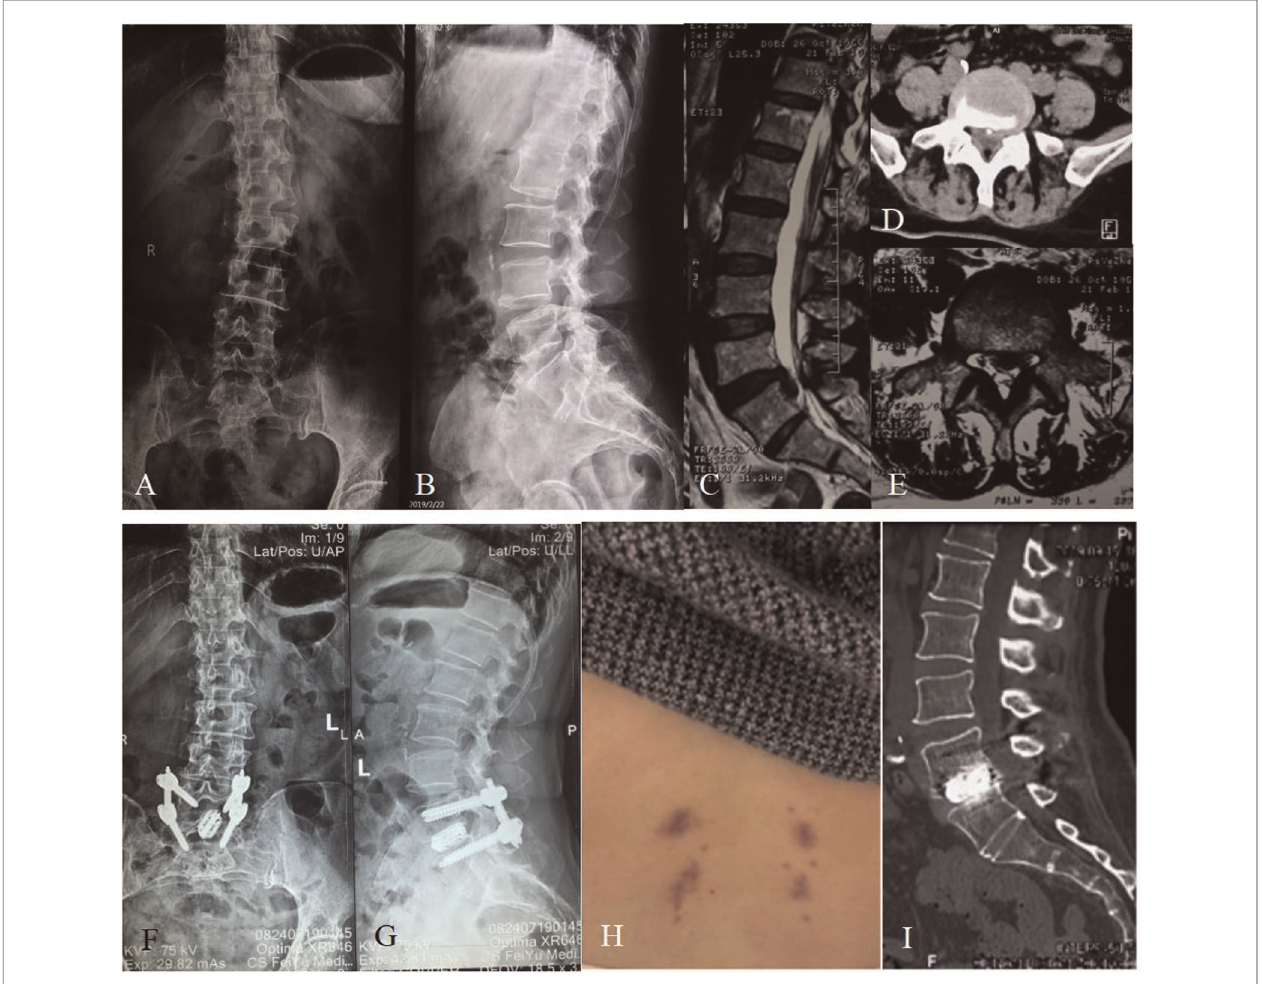
FIGURE 2 | Sixty-two-year-old female with over 10-year lumbar pain and 1-week leg pain. ( A , B ) Preoperative X-ray showing the patient had a slightly degenerative lumbar scoliosis and had no lumbar spondylolisthesis or apparent lumbar instability. ( C ) Preoperative sagittal MRI showing the patient had an L5/S1 disc herniation with downward prolapse. ( D , E ) Preoperative cross-sectional CT and MRI showing that the herniated disc with calci fi cation oppressed the left nerve root of S1. ( F , G ) The postoperative X-ray showing that the cage and pedicle screws were complete and in position. ( H ) There was a very small incision scar that healed well at the follow-up of 3 months after surgery. ( I ) The postoperative CT showing a sign of probable fusion within the interbody of L5/S1 at the follow-up of 6 months after